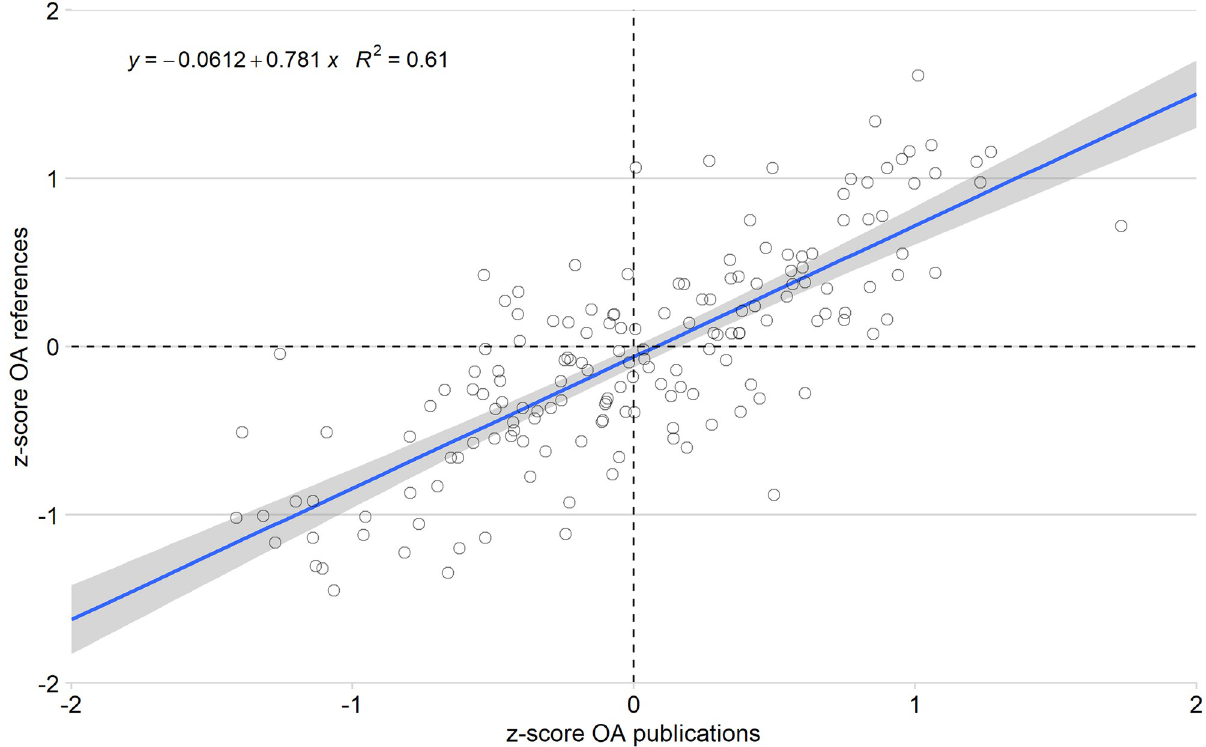
Fig 3. Correlation between normalized OA publications and normalized cited references by